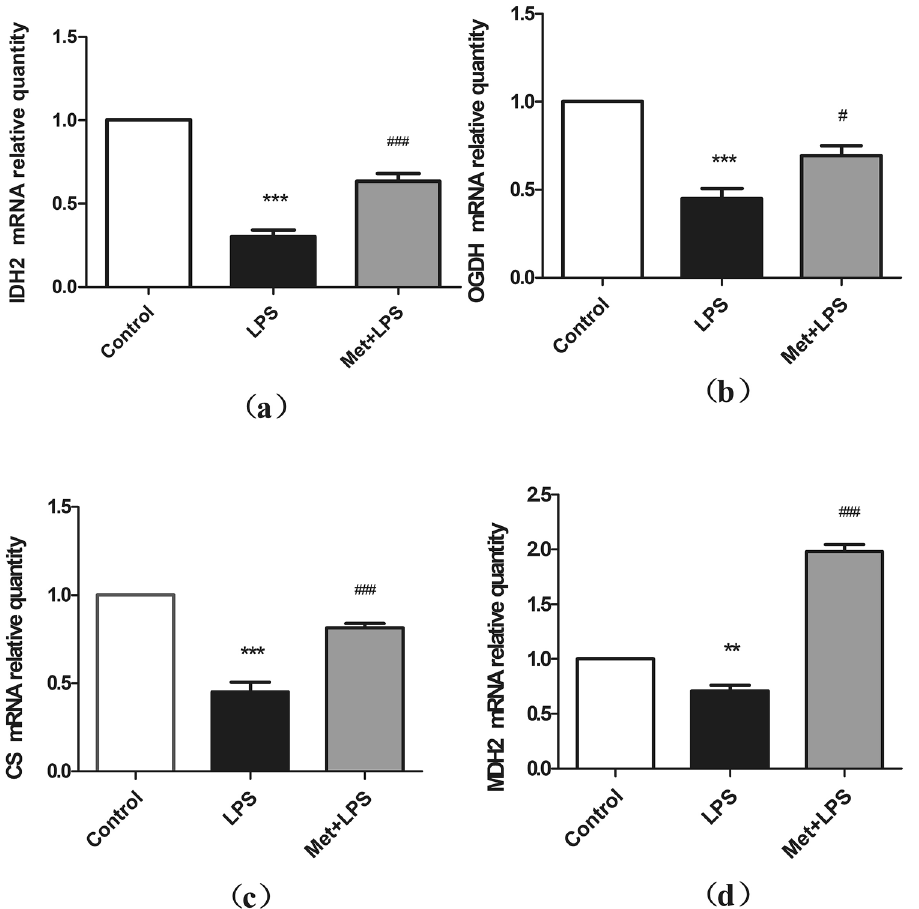
Figure 3. Effects of lipopolysaccharide and metformin on the mRNA expression levels of tricarboxylic acid cycle key enzymes in macrophages. ( a ) Isocitrate dehydrogenase 2 mRNA; ( b ) ɑ -ketoglutarate dehydrogenase; ( c ) Citrate synthase; ( d ) Malate dehydrogenase 2. LPS: lipopolysaccharide, Met: Metformin , CS: citrate synthase, IDH: isocitrate dehydrogenase, MDH: malic dehydrogenase, OGDH: α-ketoglutarate dehydrogenase. *: compared with blank control group, #: compared with LPS group. * P < 0.05, ** P < 0.01: *** P < 0.0001. # P < 0.05, ## P < 0.01, ### P <